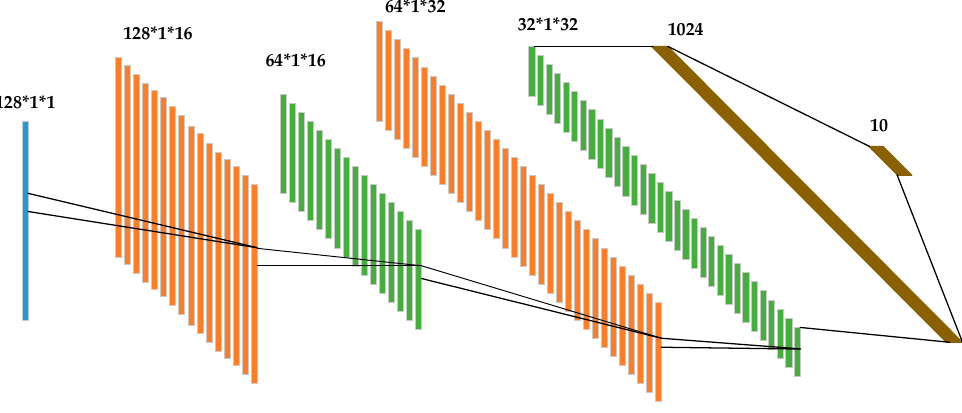
Figure 1. Schematic diagram of the CNN structure for HRRP. It shows CNN’s classification process of 10 types of targets for 128-length HRRP